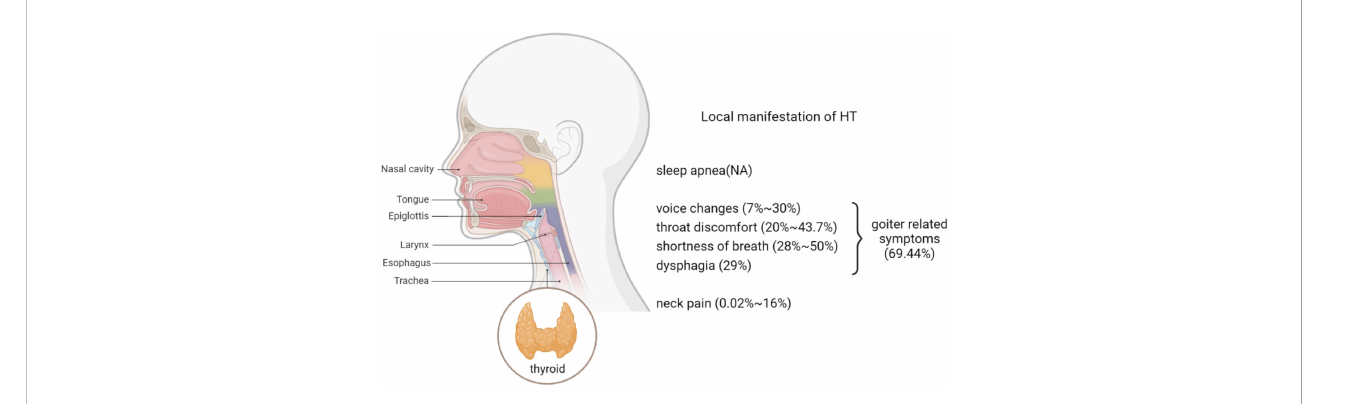
FIGURE 2 Prevalence of local symptoms.